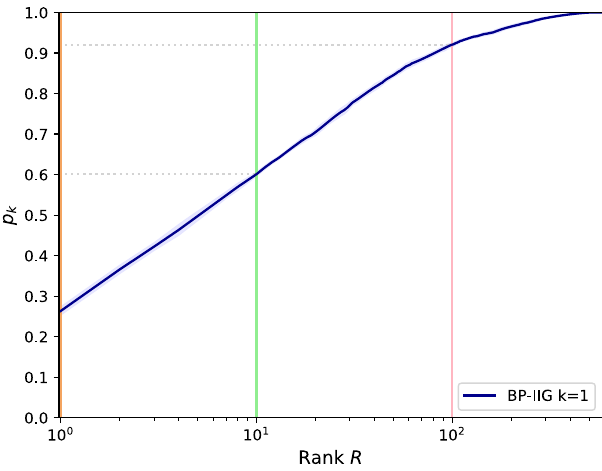
Fig. 7 Probability of identi fi cation in a bluetooth close-proximity network. We plot p k = 1 , the probability of identi fi cation within rank R for k = 1. The 95% con fi dence interval is shown in light blue. Our method correctly identi fi es people p k = 1 = 26.4% of the time based on their 1-IIGs. Out of 10 people ( R = 10), it is able to identify the right person p k = 1 = 60.1% of the